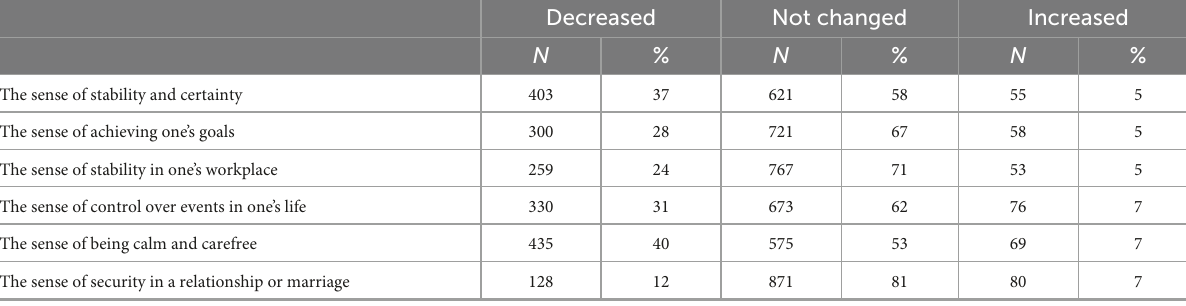
TABLE 4 The influence of the pandemic on one’s mindset.